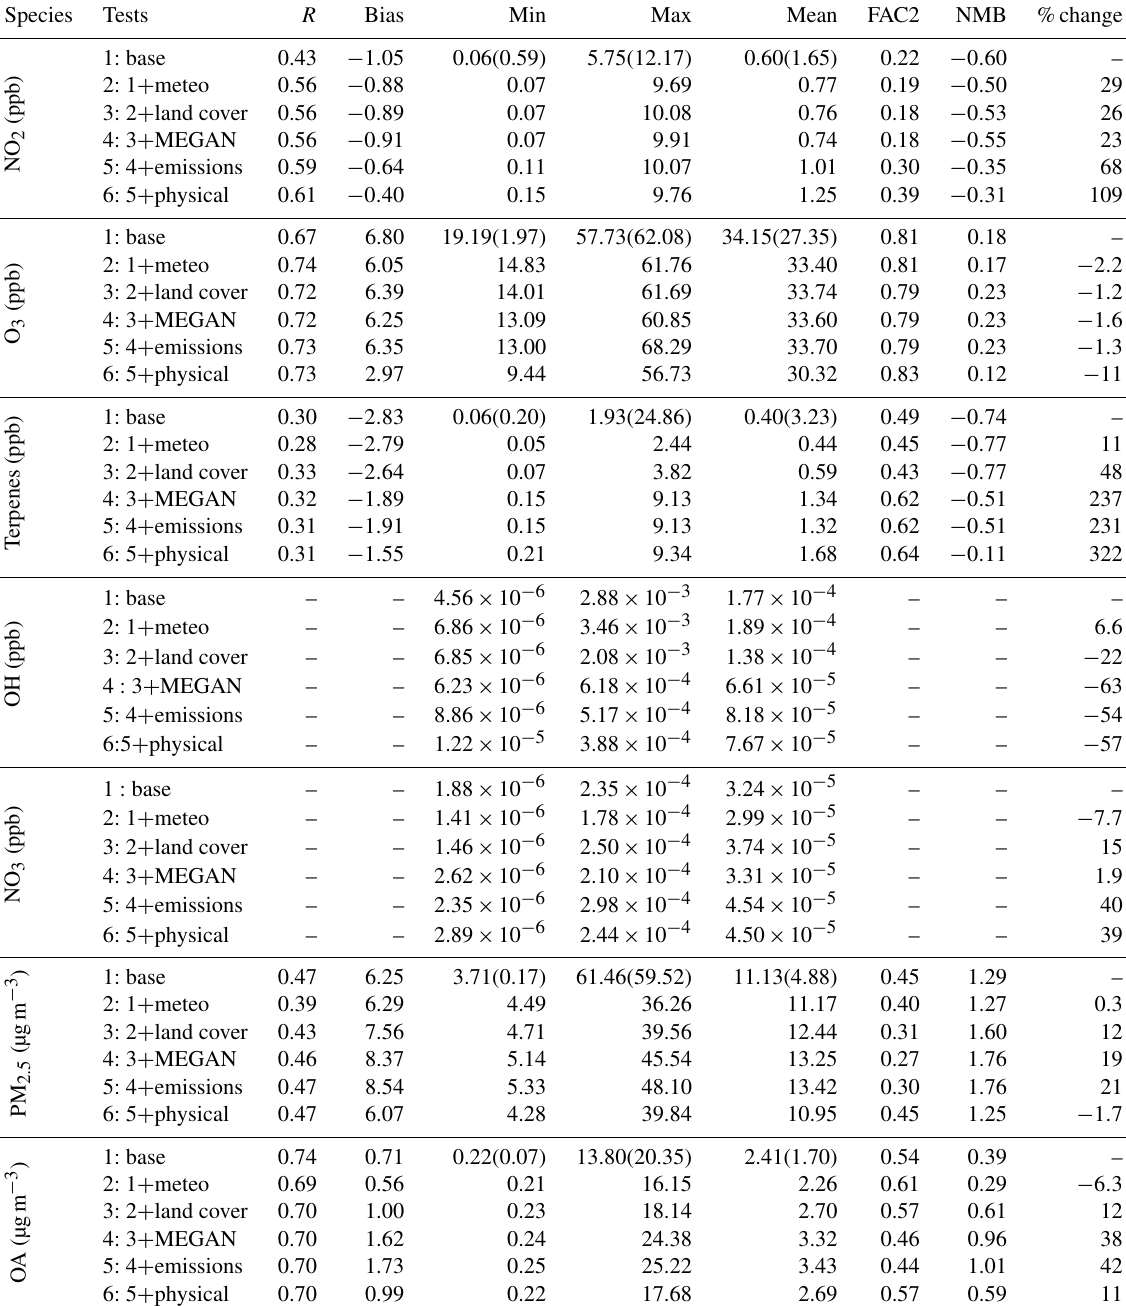
Table 2. Statistical information for test cases showing correlation coefficient to measurements ( R , when possible); bias (absolute difference between model and measurement averages); minimum, maximum, and average values (min, max, and mean); fraction of predictions within a factor of 2 of observations (FAC2); normalized mean bias (NMB); and the percentage of change in the mean for each test case compared to the base simulation. When measurement data were available, their value is given in parentheses. The units and the species names are given on the left side of the table. Percentage (%) change indicates the relative change in simulated means with respect to the base